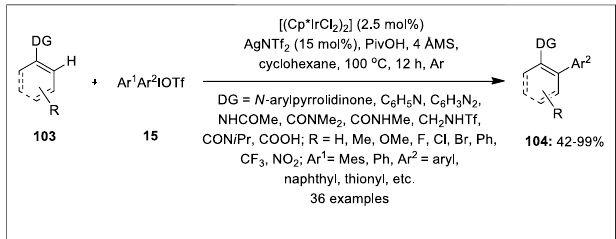
FIGURE 20 | Iridium-catalyzed C – H arylation of arenes and ole fi ns 103 using diaryliodonium salts 15 as an arylating